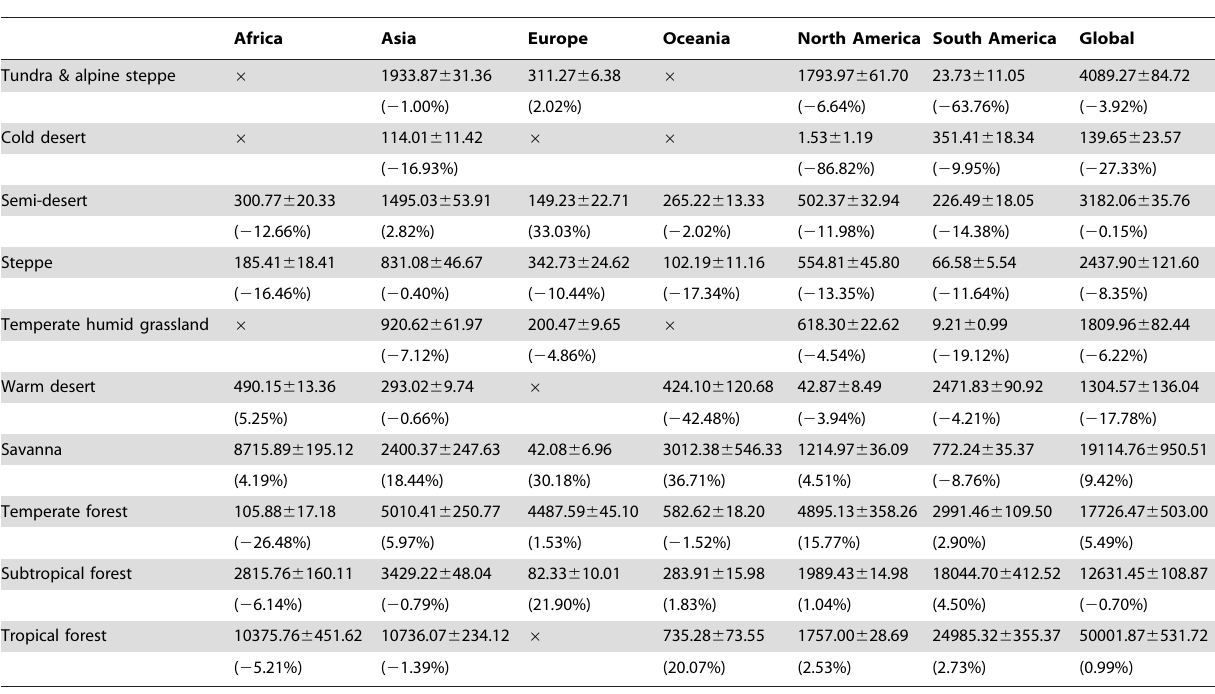
Table 3. NPP of terrestrial ecosystems at continental levels in 1911-2000.